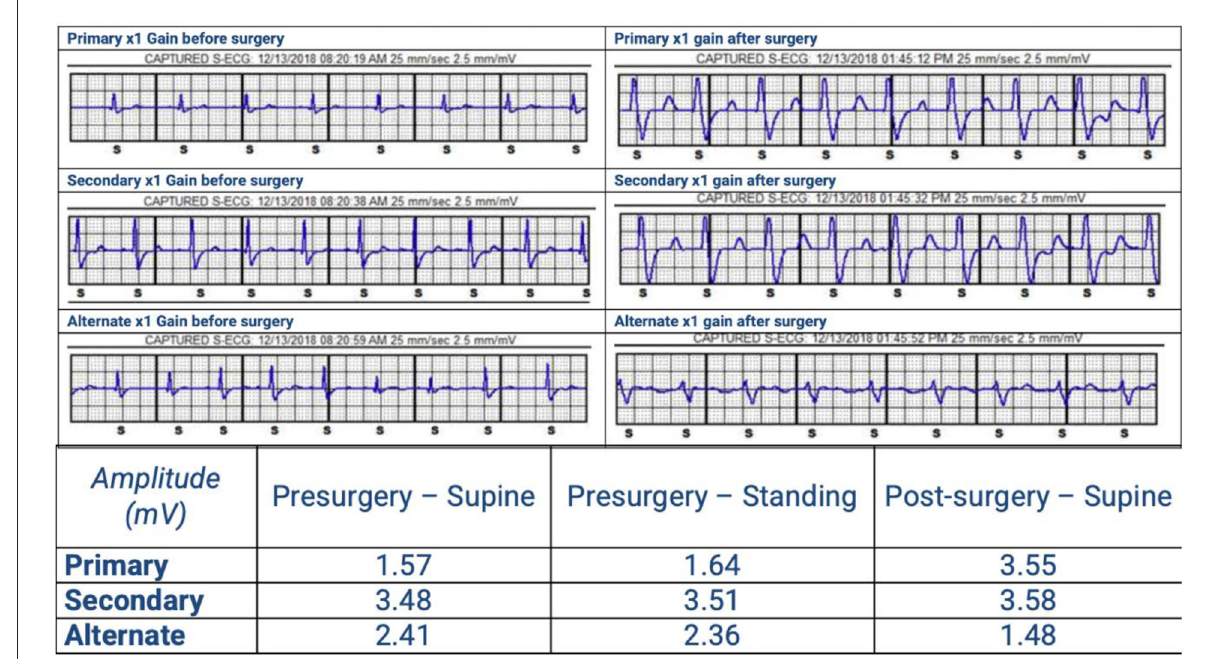
FIGURE3 SICD vector analysis pre and after surgery. The primary vector failed due to high R-wave (out of range) and the secondary and alternate vectors failed due to low R:T